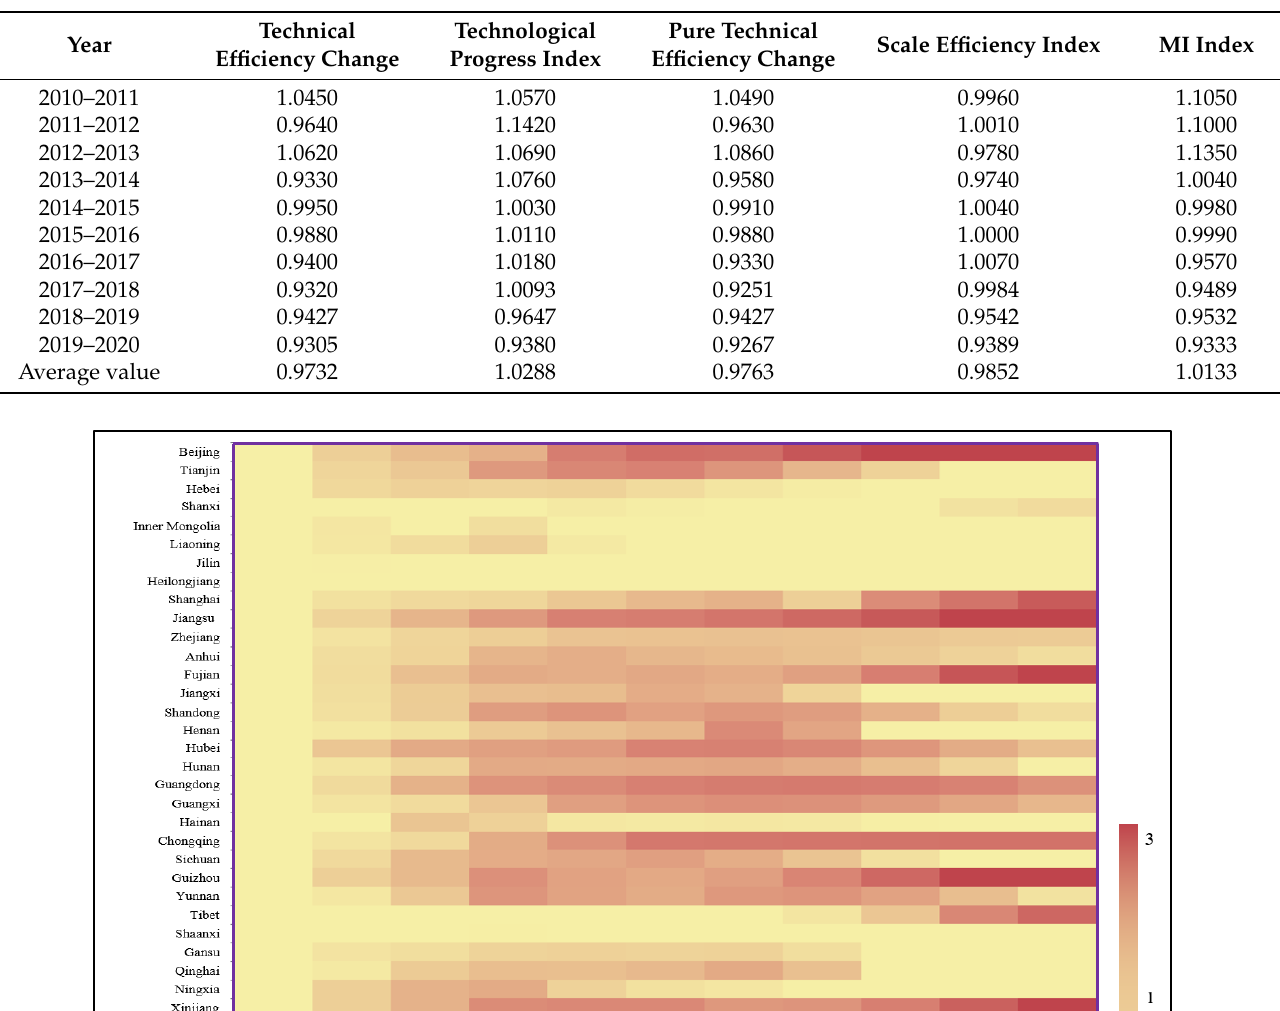
Table 5. The decomposition index of the DEA-Malmquist model in 2010–2020.